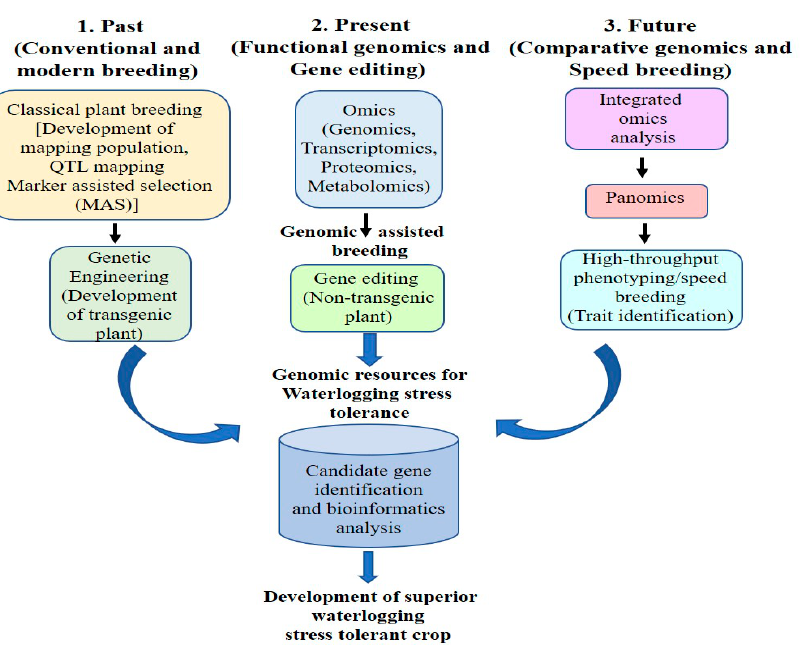
Figure 3. Strategies for improving waterlogging tolerance in plants highlighting (1) Past: conventional and modern breeding approaches (i.e., mapping population and genetic engineering), (2) Present: omics and gene-editing approaches, and (3) Future: comparative genomics (i.e., integrated omics and panomics) and high-throughput phenotyping (speed breeding) approaches. Furthermore, we have presented how the integration of all genomic resources and bioinformatics analysis data would help in the identification of candidate genes for developing a superior cultivar for waterlogging stress tolerance.